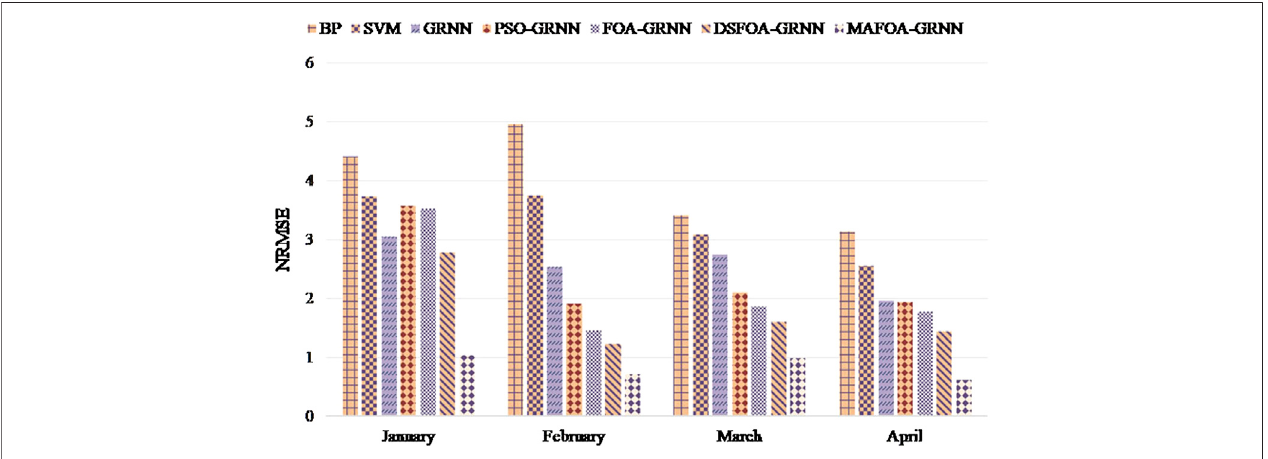
FIGURE 7 | Performance comparison of models in terms of NRMSE